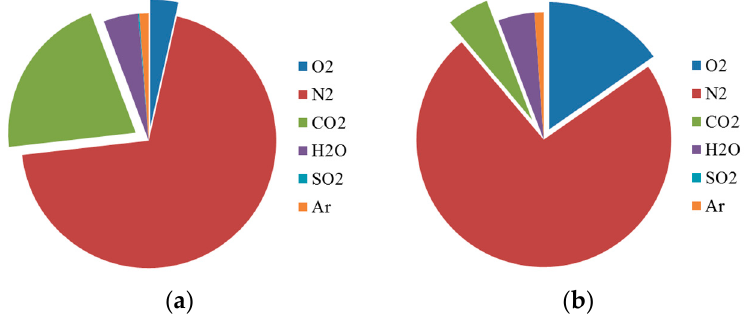
Figure 7. Specific off ‐ gases emissions for ( a ) base case; and for ( b ) repowering with SOFC.